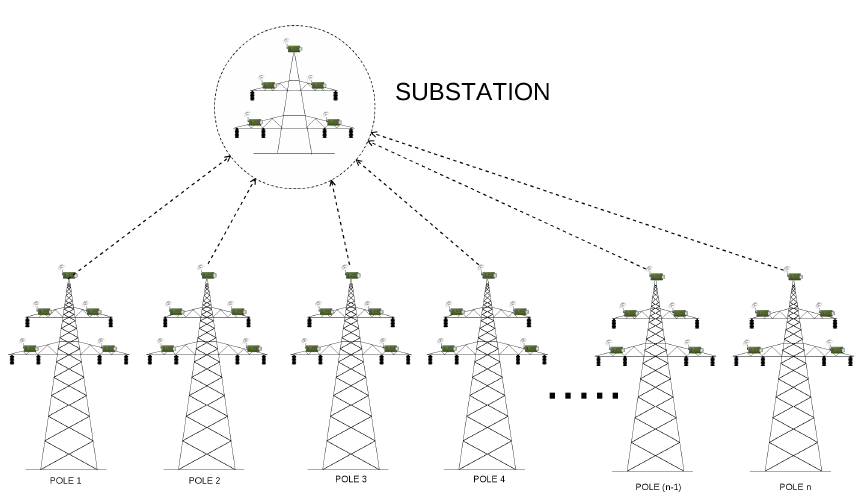
Figure 5. WSN architecture deployed on the example transmission grid, where η = 1.